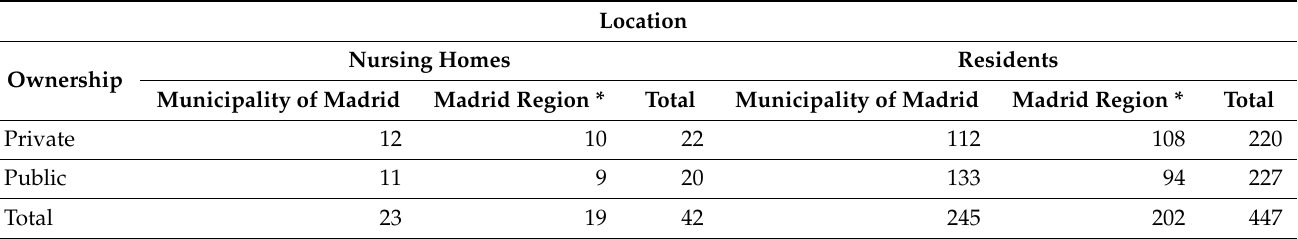
Table 1. Distribution of cases according to ownership and